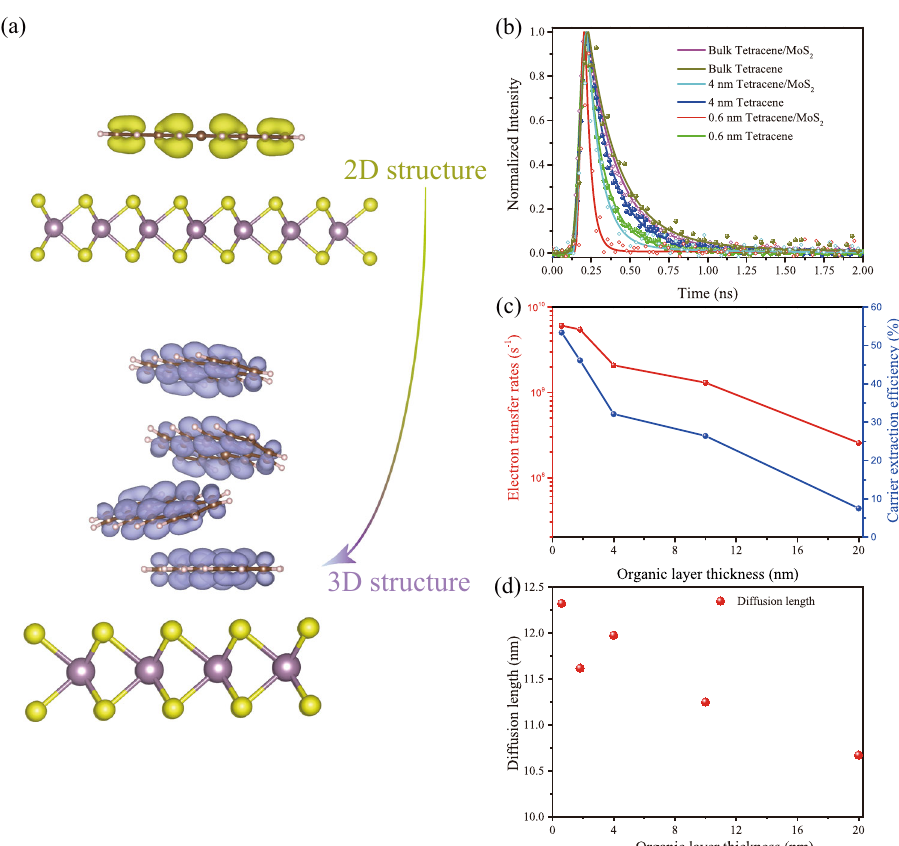
Fig. 3 Interlayer carrier transfer and exciton diffusion process with various organic layer thicknesses. a The DFT calculations of charge distribution from 2D to 3D organic-inorganic structures. b Normalized time-resolved PL decay pro fi les of tetracene layer in tetracene/MoS 2 heterostructures with various thicknesses. c The electron transfer rates (red line) and the carrier extraction ef fi ciency (blue line) in tetracene/ MoS 2 O-I heterojunction. d The results of the exciton diffusion length with different organic layer